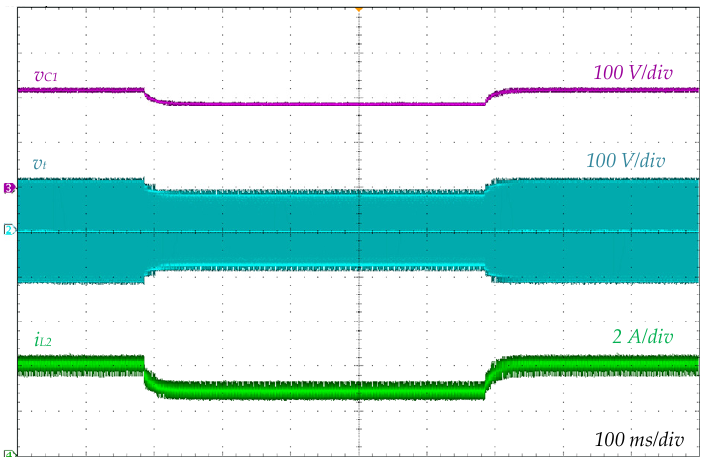
Figure 15. Experimental results for the batteries’ charge process, including constant current charge mode and constant voltage charge mode.